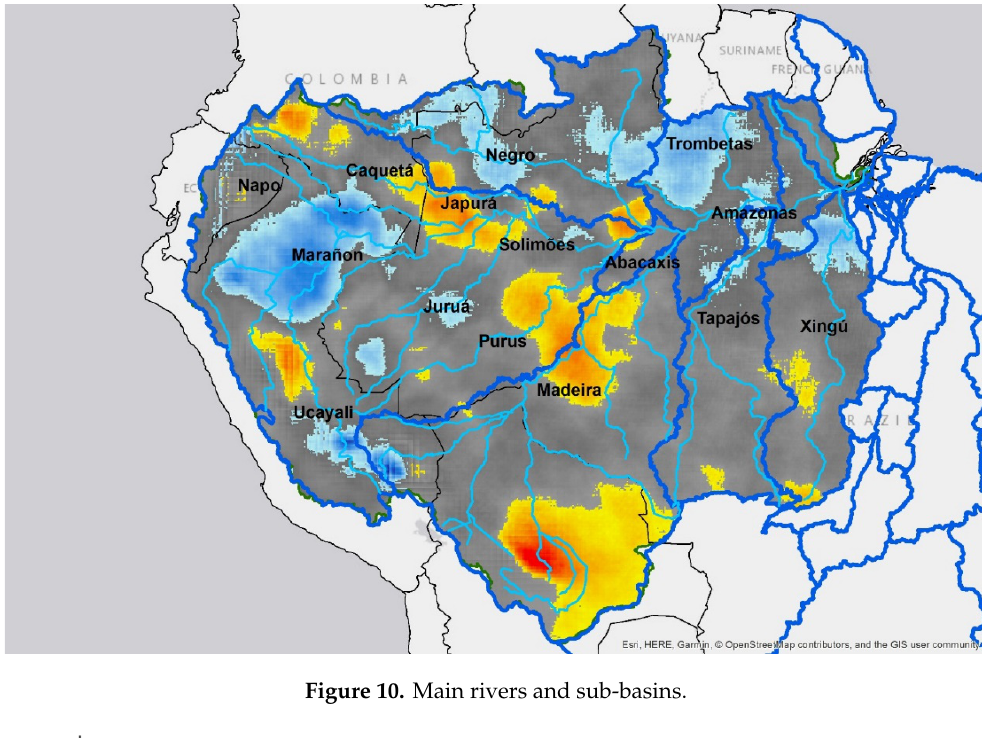
Figure 10. Main rivers and sub-basins.